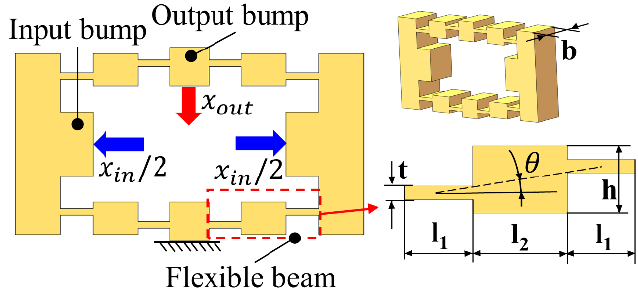
Figure 1. Classical bridge mechanism.